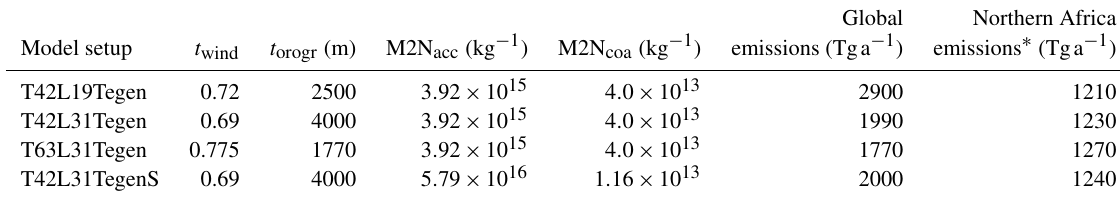
Global Northern Africa